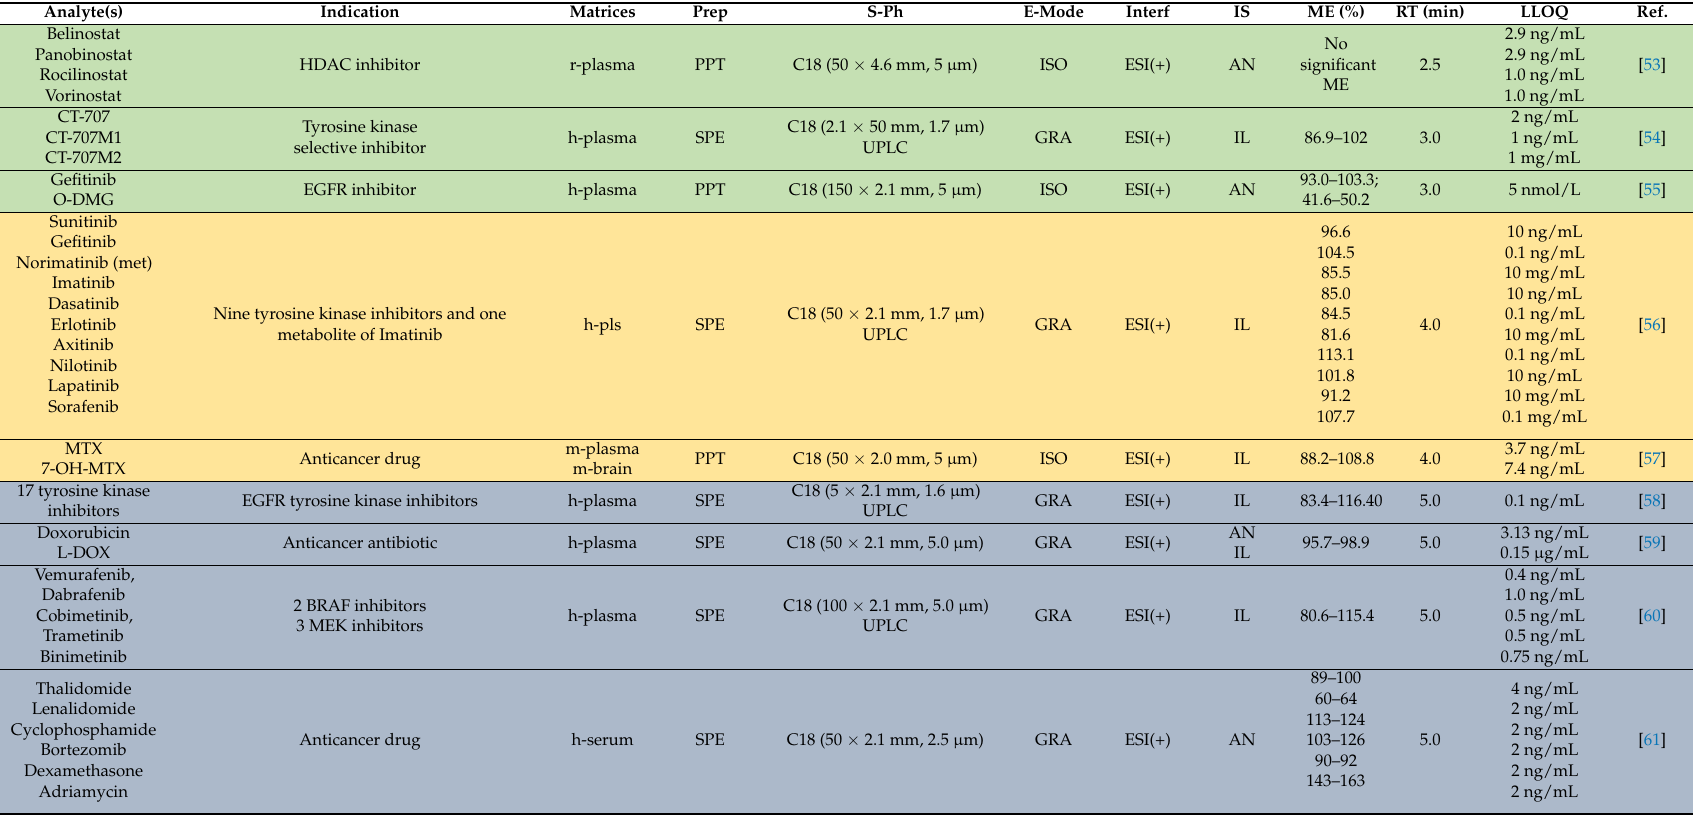
Table 2. LC-MS/MS methods for determination of two or more